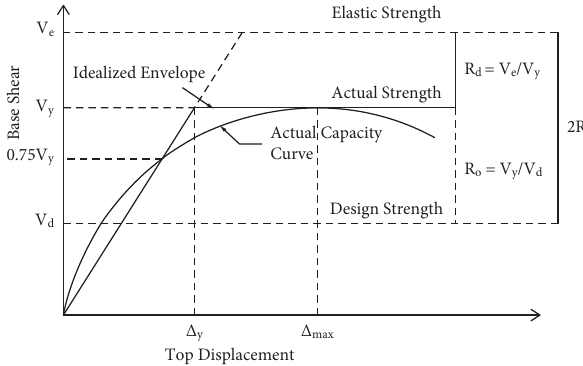
Figure 2: The relationship between R , R d , and R o factors. Table 1: Response reduction factor by IS1893 (Part 1): 2016 [39].